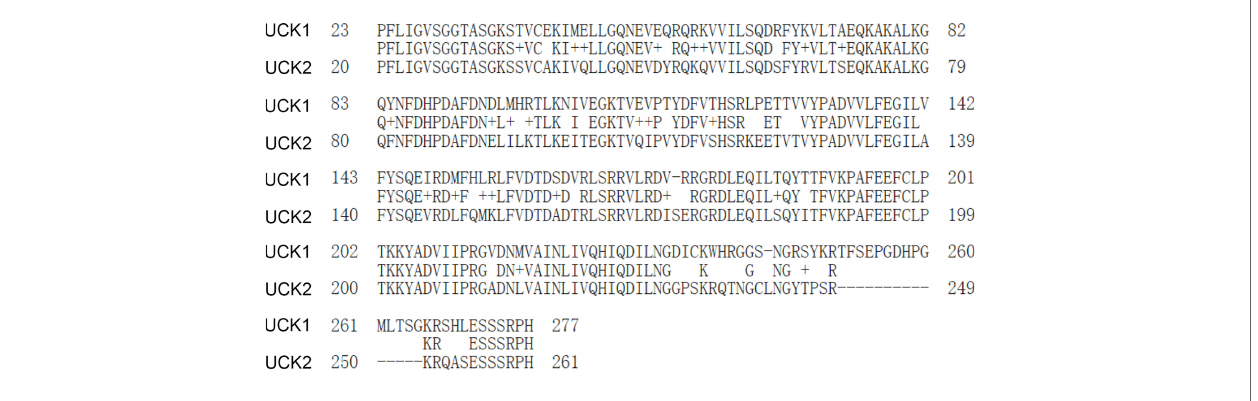
FIGURE 1 | The alignment of the protein sequences of UCK1 and